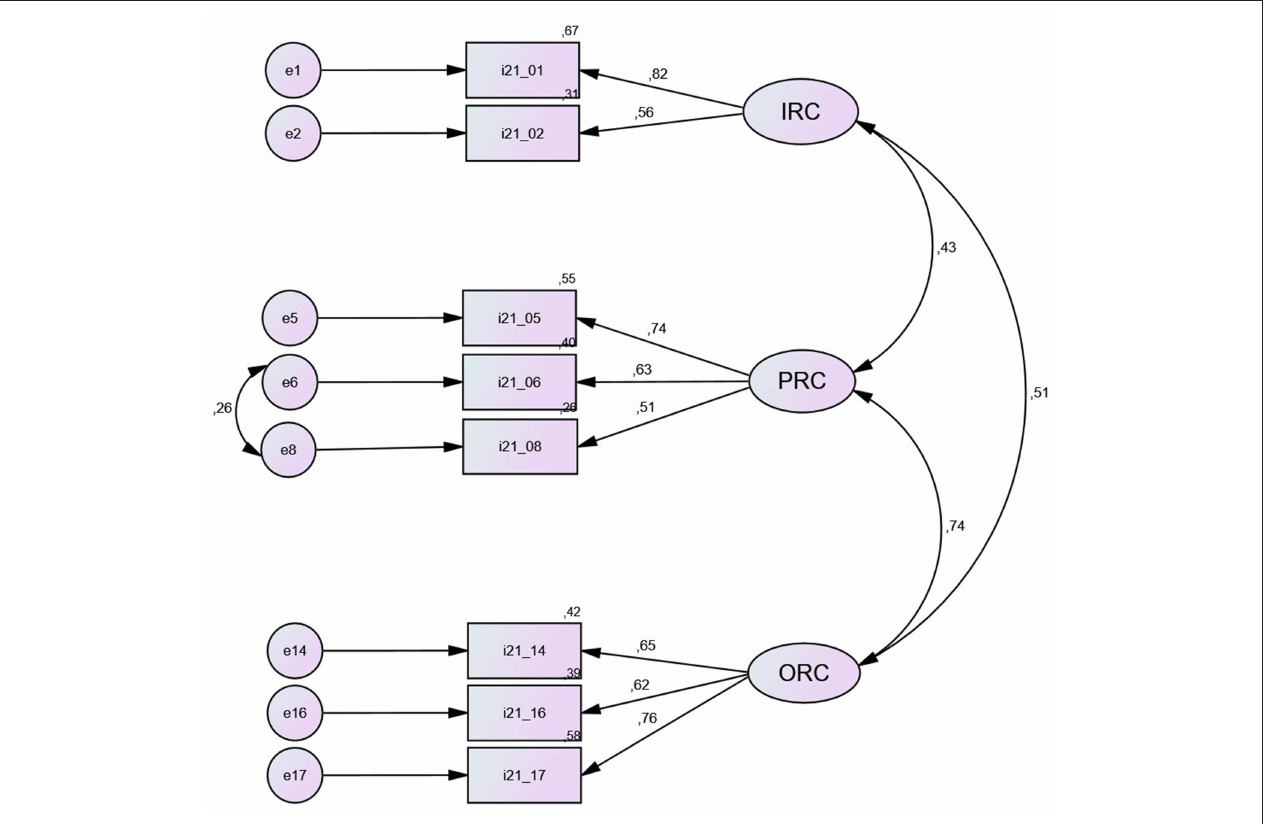
FIGURE 2 | Final measurement model with standardized values and regression weights.